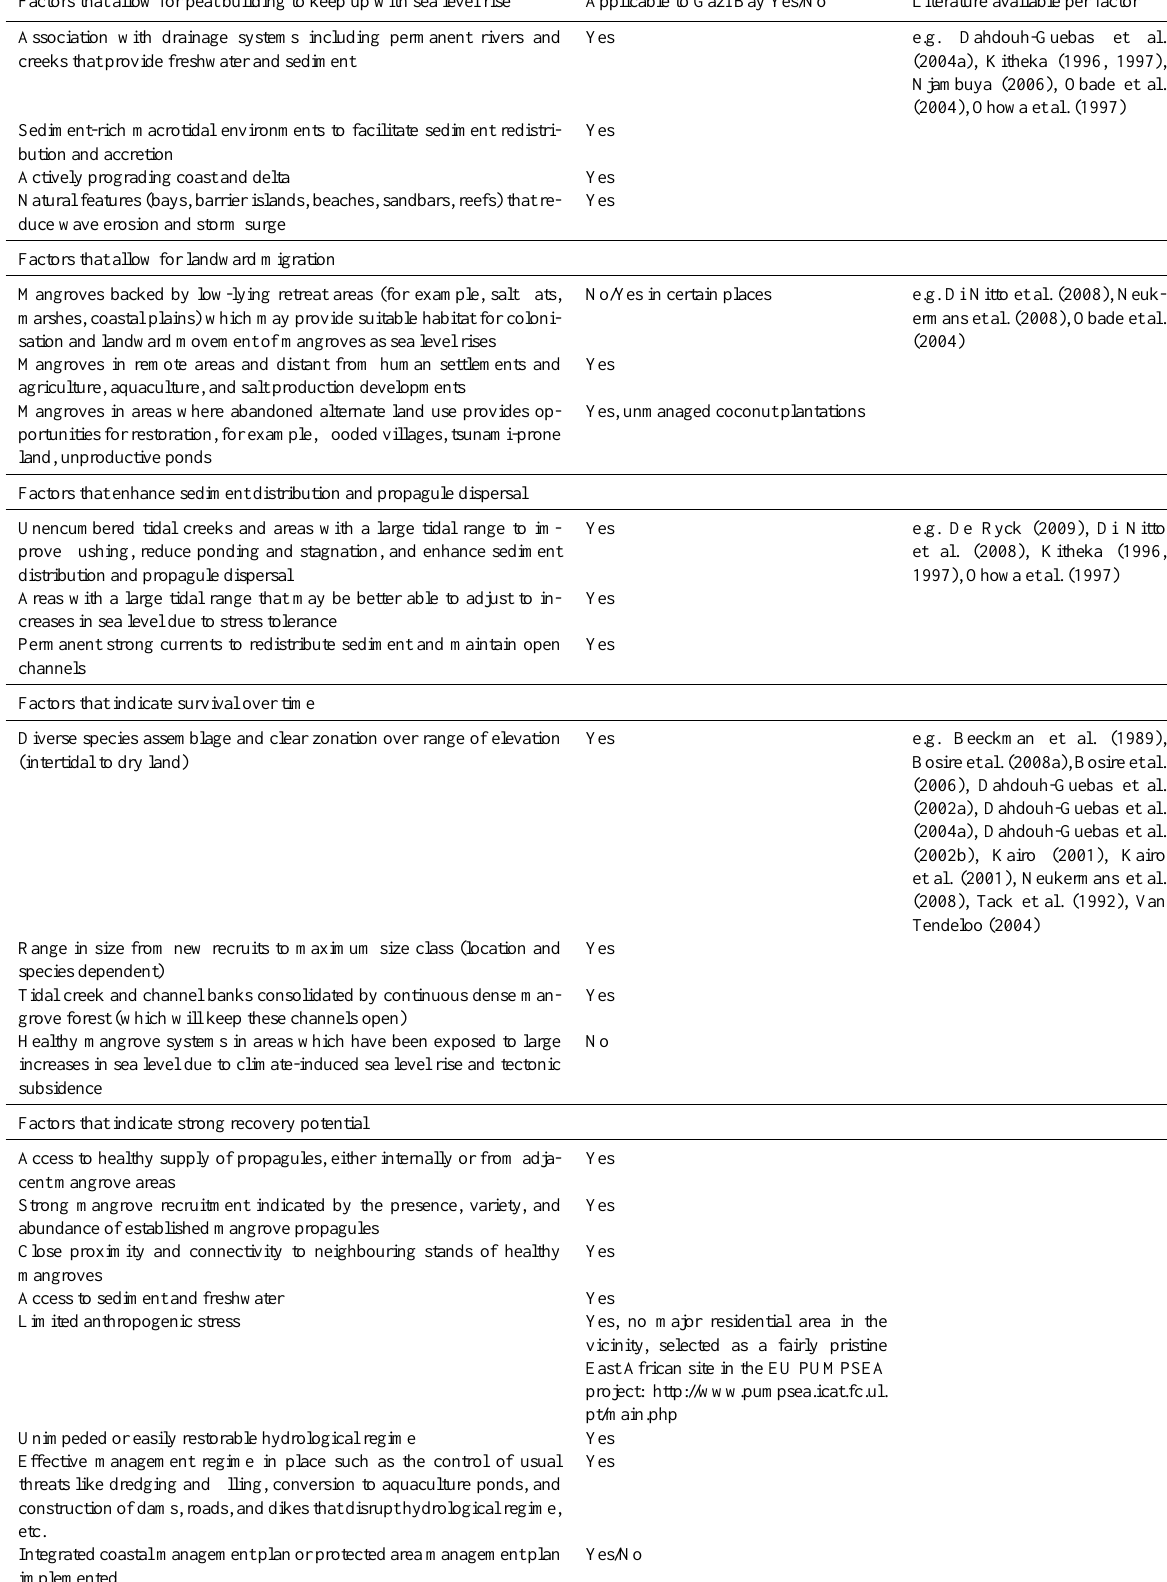
Table C1. Mangrove resilience factors that contribute to site selection (according to McLeod and Salm, 2006). Case study: Gazi Bay, Kenya. Factors that allow for peat building to keep up with sea level rise Applicable to Gazi Bay Yes/No Literature available per